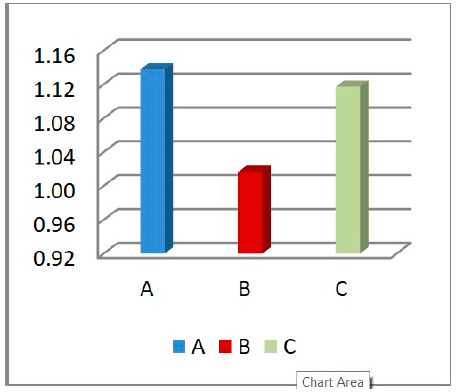
Figure 9. RFd/P–time history, for 3 different cell dimensions A, B and C with 𝜃 = 60°, t/L = 0.2, subjected to same loading conditions.